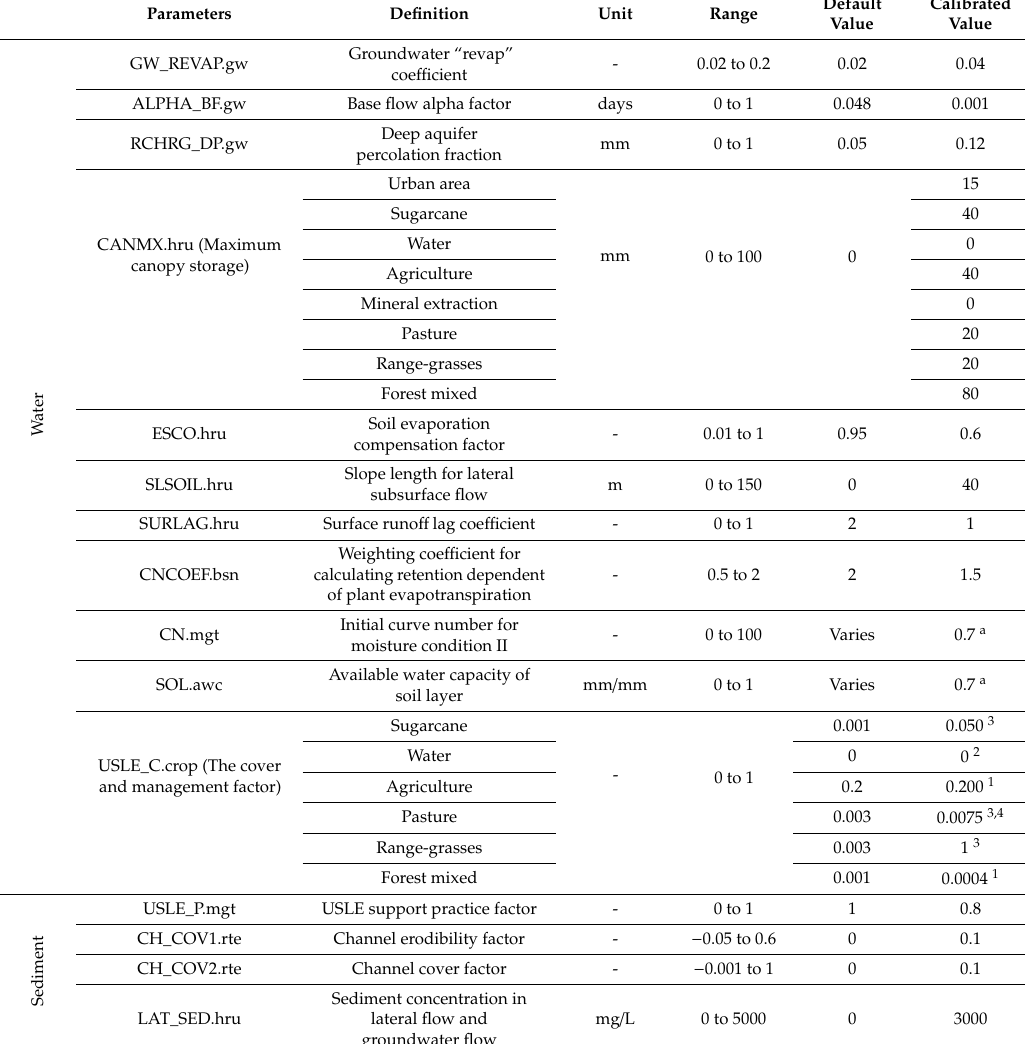
Table 5. Calibrated parameters of SWAT model with their default and calibrated